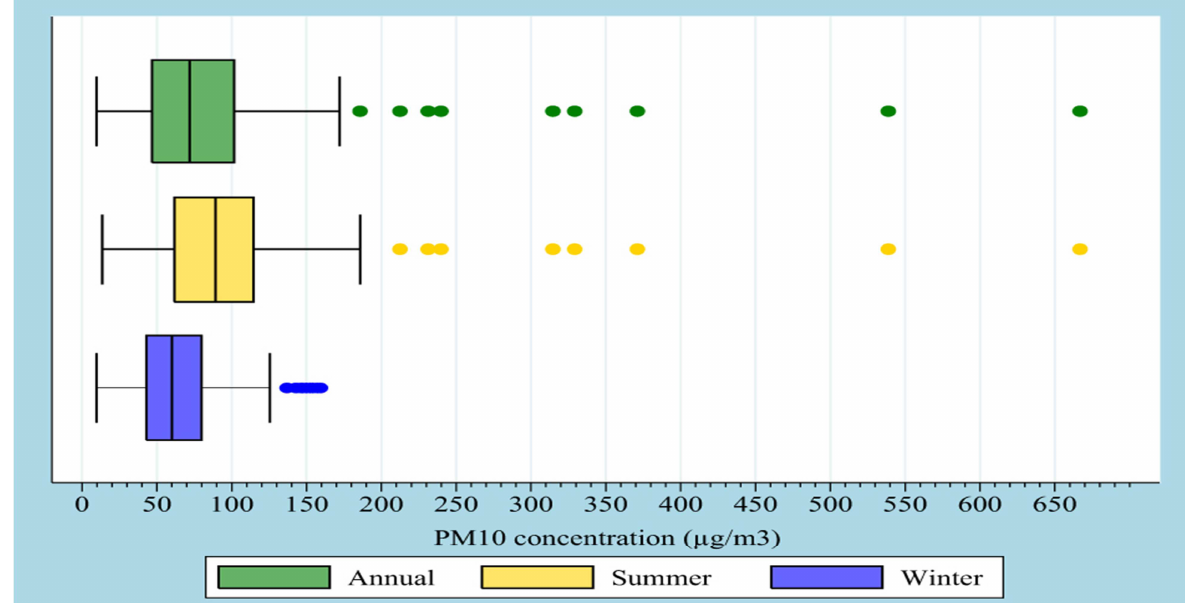
Figure 2. Descriptive statistics of measured particulate matter with aerodynamic diameters <10 µm concentrations in Sanandaj, Iran, in